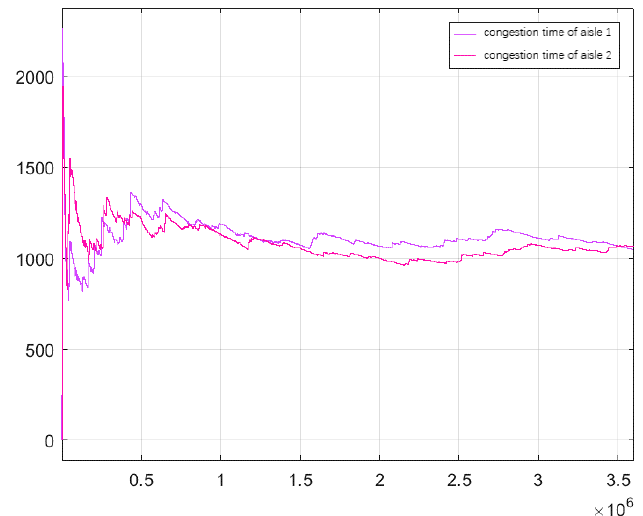
Figure 7. The congestion time curves of the aisles.